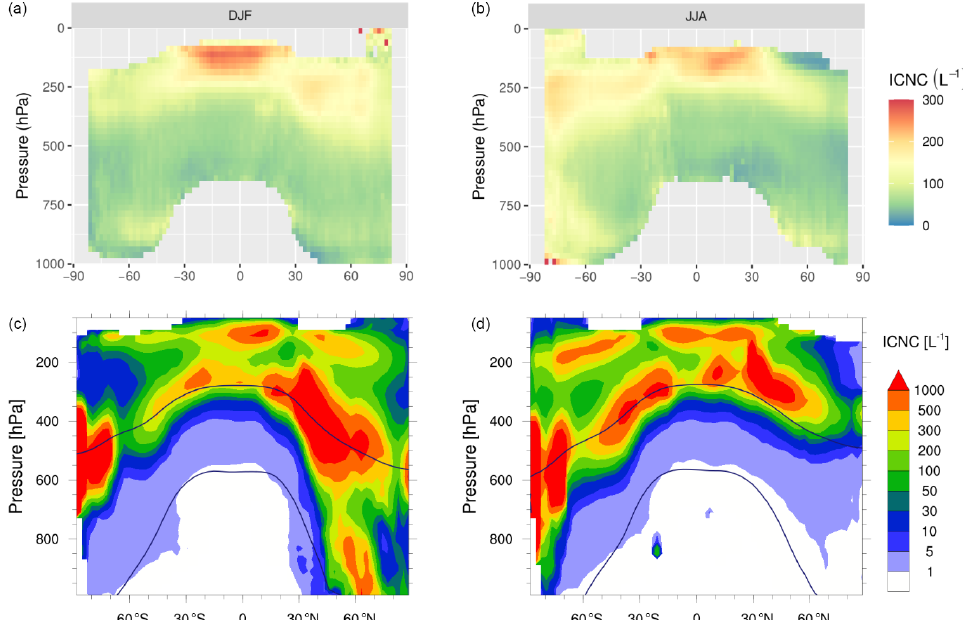
Figure 2. Zonal means of in-cloud ICNC for the DJF and JJA seasons by DARDAR-Nice (a, b) and EMAC (REF, c, d ); the isotherms at 0 and − 35 ◦ C are seasonal